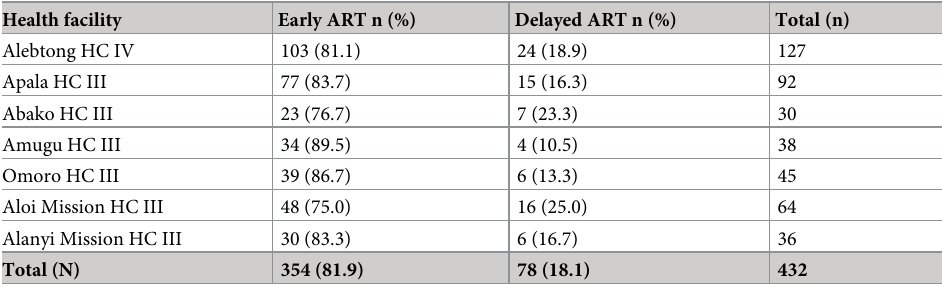
Table 2. ART initiation status at health facilities offering ART services in Alebtong